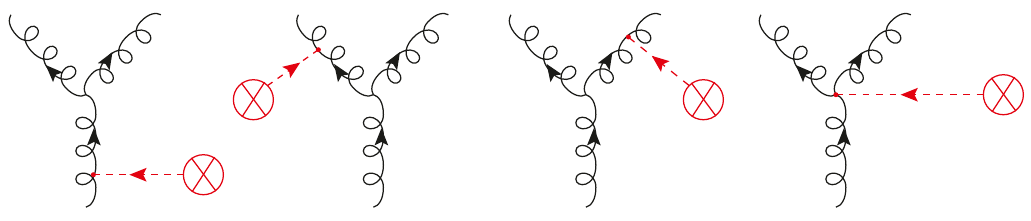
Figure 1 . Gluon scattering in the background of dilaton field.